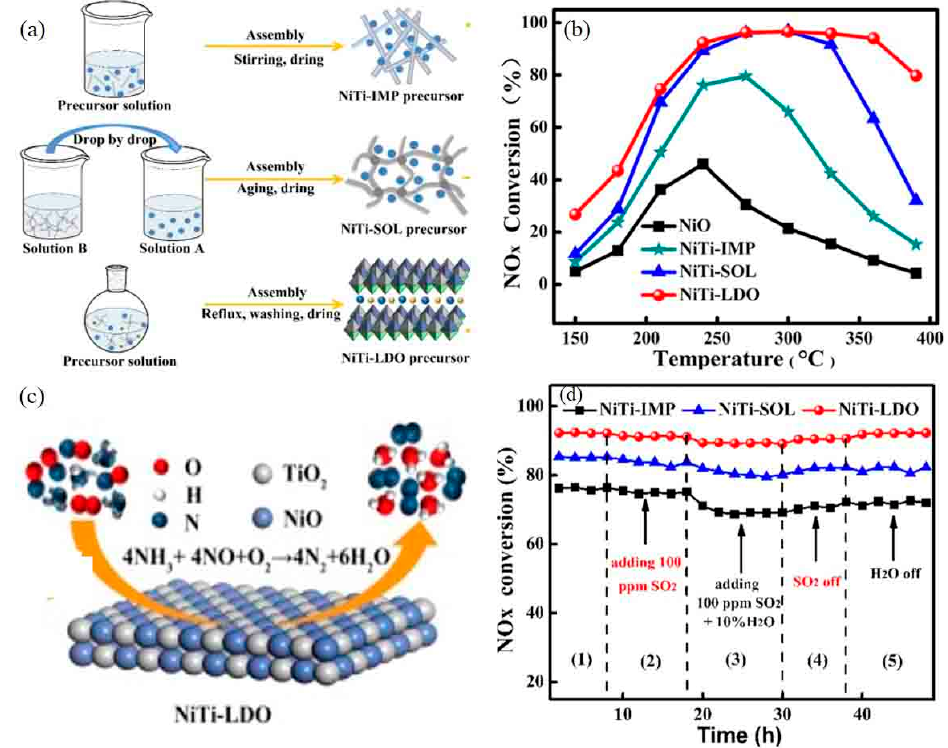
Figure 10. ( a ) Different preparation processes of Ni–Ti hydrotalcite-like precursors, ( b ) NO Figure 10. ( a ) Di ff erent preparation processes of Ni–Ti hydrotalcite-like precursors, ( b ) NO conversion conversion of catalysts obtained by different preparation processes, ( c ) mechanism of NO removal of catalysts obtained by di ff erent preparation processes, ( c ) mechanism of NO removal induced by TiO 2 induced by TiO 2 on the surface of NiO modified catalysts, and ( d ) sulfur resistance of Ni–Ti on the surface of NiO modified catalysts, and ( d ) sulfur resistance of Ni–Ti hydrotalcite-like precursors hydrotalcite-like precursors at 240 °C [167]. Reproduced from Ref. [167], Copyright 2019, Elsevier. at 240 ◦ C [167]. Reproduced from Ref. [167], Copyright 2019,